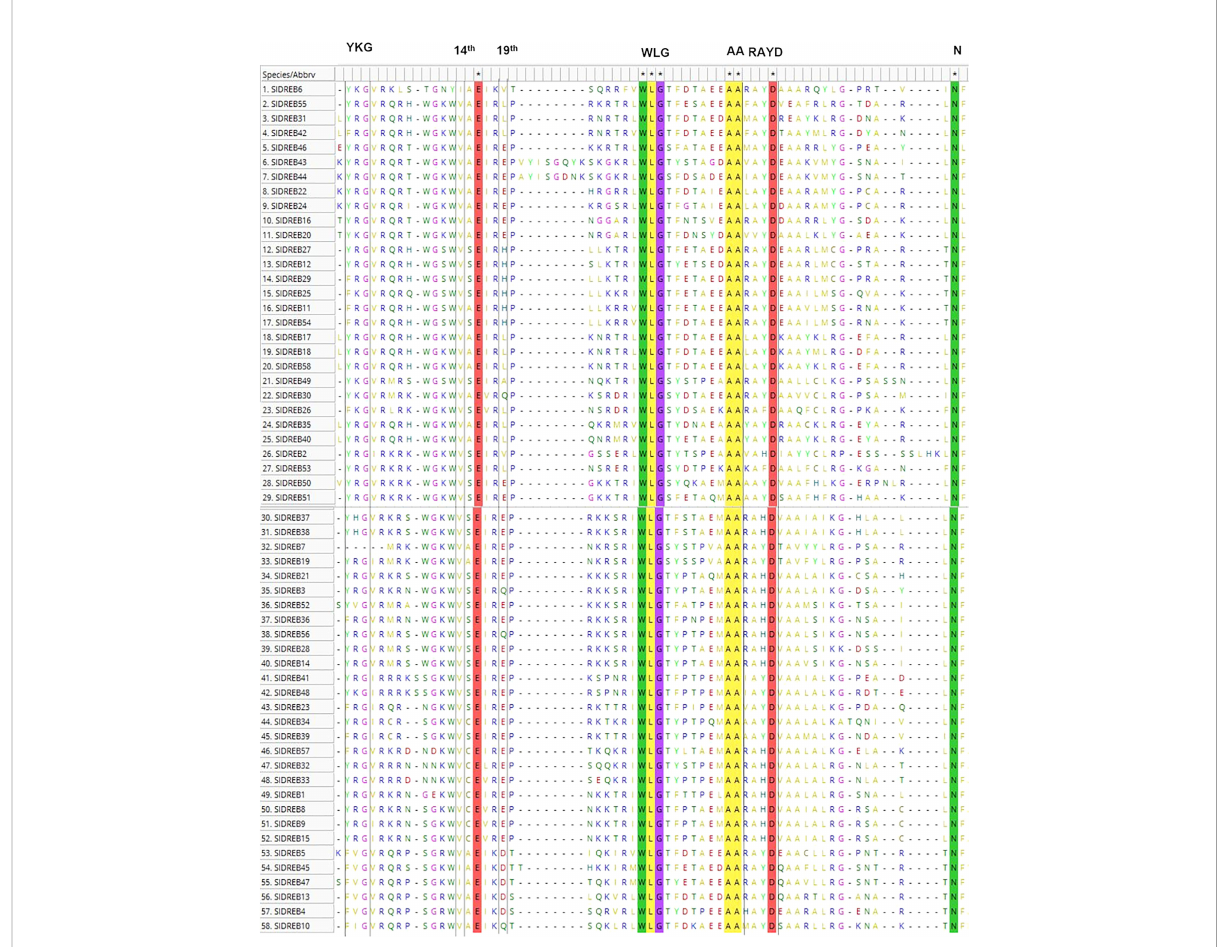
FIGURE 1 Multiple sequence alignment of S. lycopersicum dehydration-responsive element-binding (DREB) proteins. MEGA 11 software was employed using MUSCLE algorithm. The highlighted lines represent conserved amino acids and motifs, whereas motifs and amino acids enclosed in black lines represent variability and have active roles in protein structure and